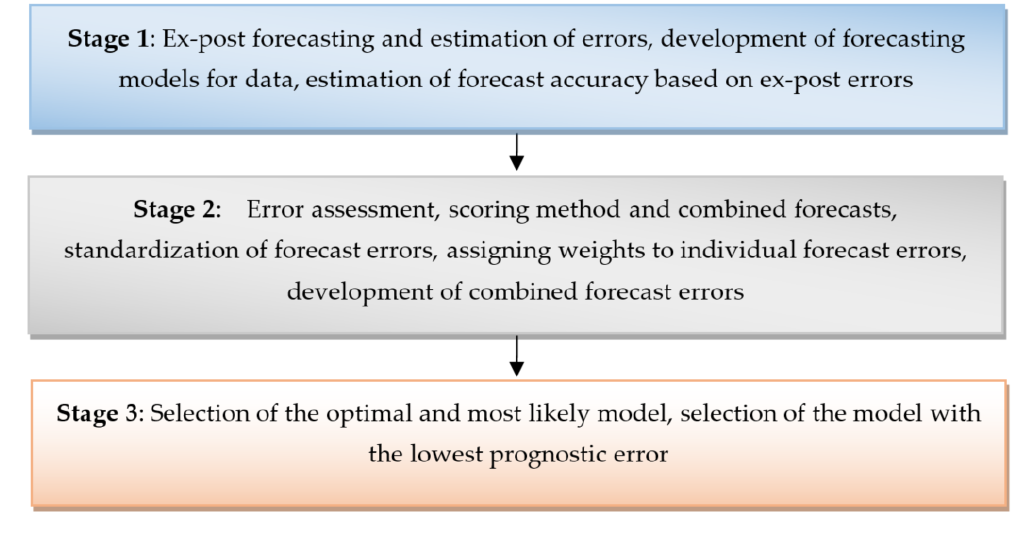
Figure 3. Methodology of own research (own elaboration).